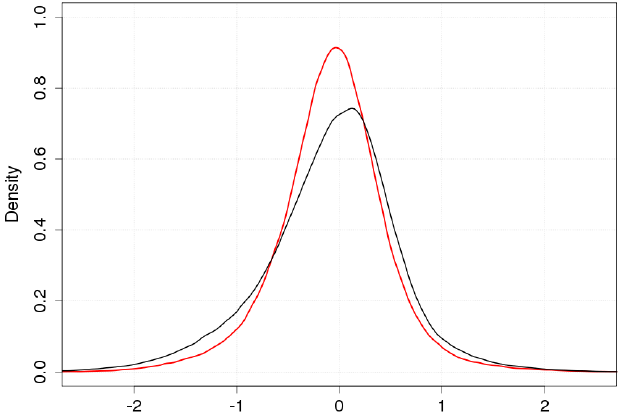
Figure 4. Histograms of ∆ SST = SST sat − SST buoys (black line) and ∆ (cid:100) SST = SST corr − SST buoys with correction by random forest model on test sample (red